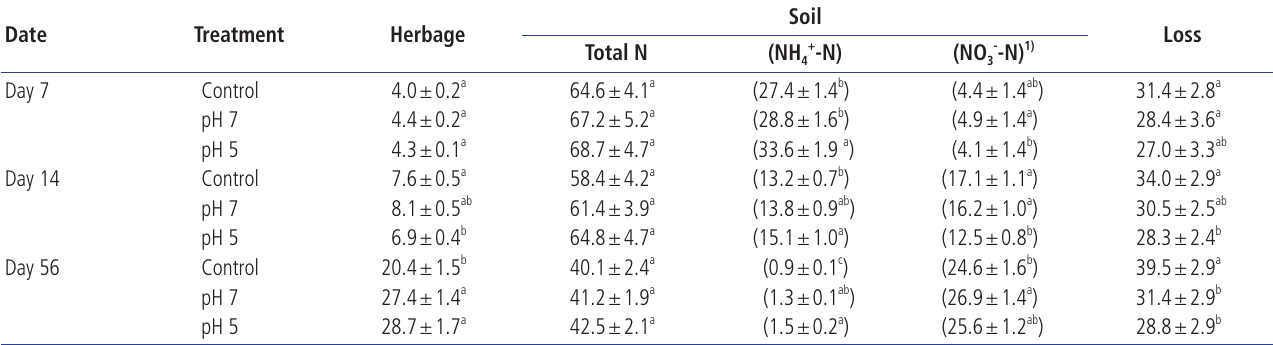
Table 5. Recovery percentage of pig slurry urea- 15 N in herbage and soil, and calculated loss (not recover in herbage or soil) as affected by pH control of pig slurry during regrowth of perennial ryegrass